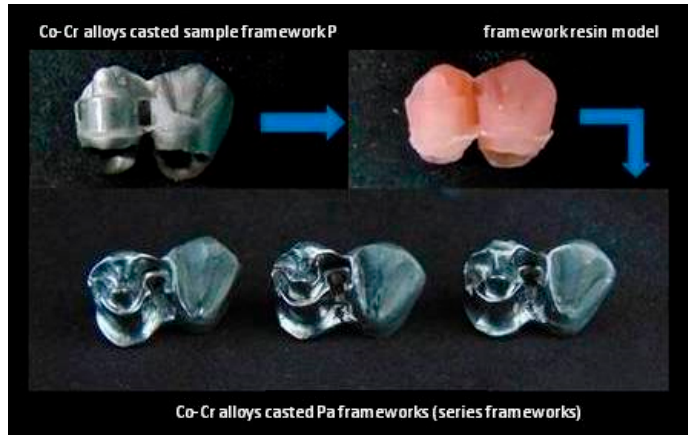
Figure 5. Diagram of the transition from framework P (individual framework) to the series produc- tion of Pa frameworks by using the Ma framework wax model.